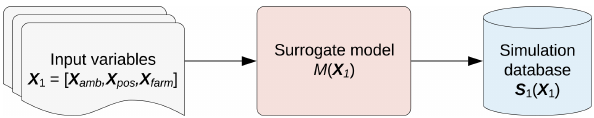
Figure 3. Schematic illustration of site-specific wind farm load es- timation using surrogate